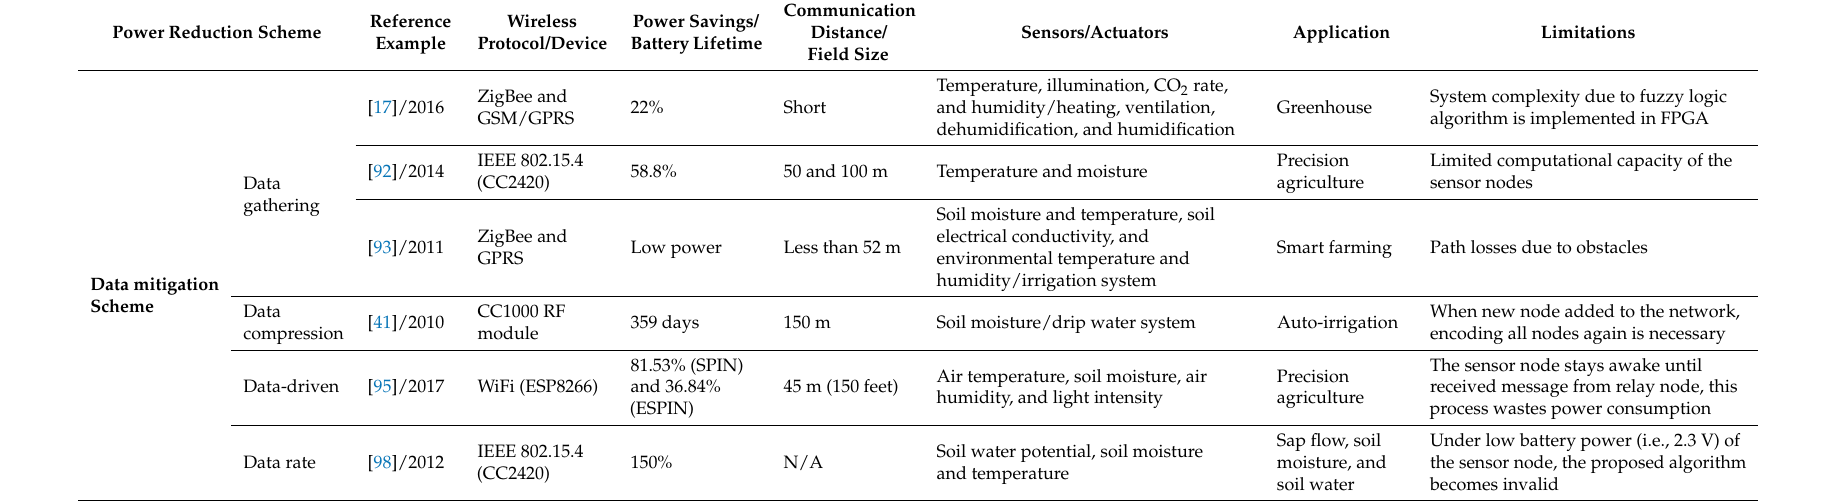
Table 4. Data mitigation schemes for previous research in agricultural